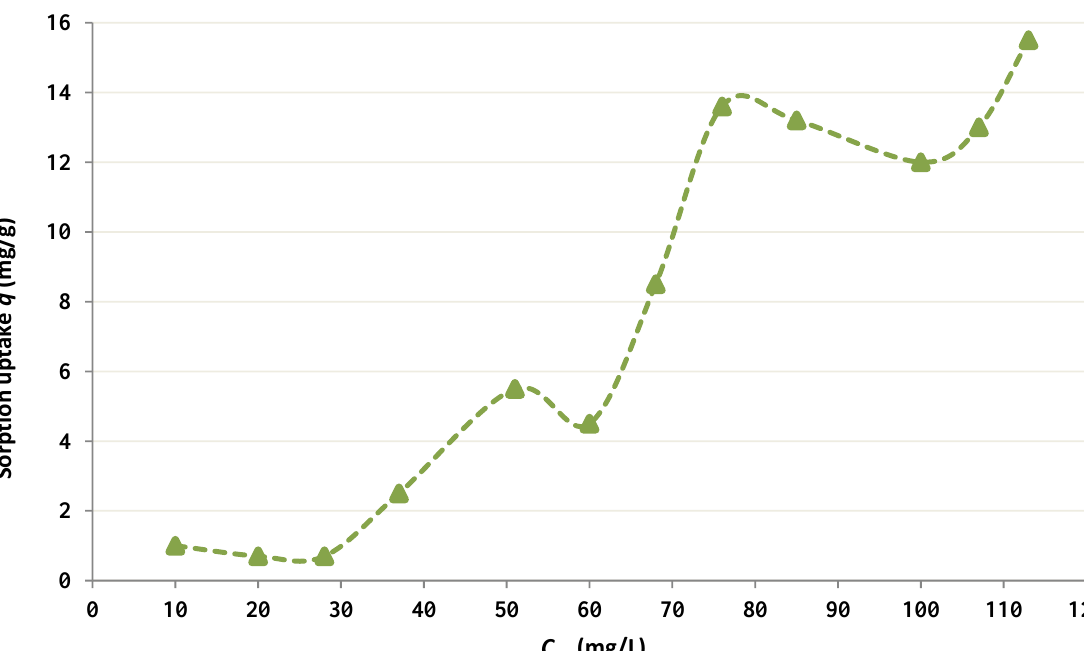
Figure 2. Adsorption isotherm for Co by chitin at pH = 4.